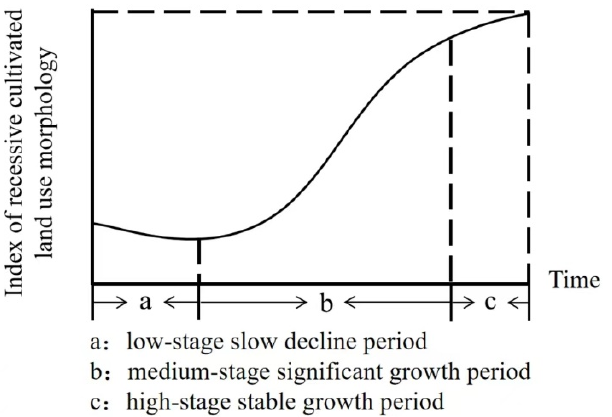
Figure 7. Transition mode of recessive cultivated land use